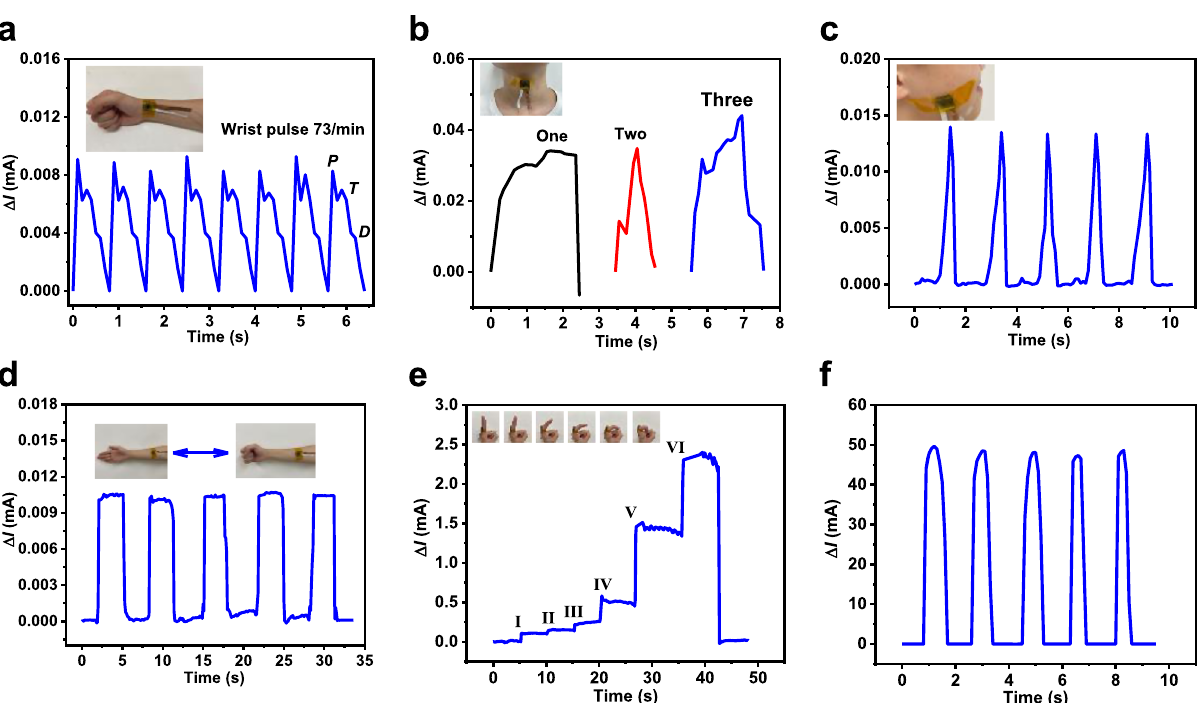
Fig. 6 Wearable demonstration. a The current response caused by the arterial pulse waves with the sensor attached to the wrist. b The recorded current signal versus time pronouncing. Finally, c the signal variations of relative current corresponding to different occlusion, d human palm, e fi nger motion, and f